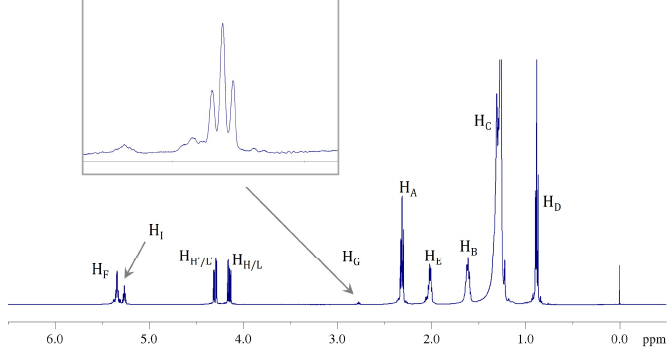
Figure 7. 1 H NMR spectrum (500 MHz, 298 K, in CDCl 3 ) of CB (sample A) in which the signal attributions to the different functional groups of FAs in TAGs are shown.